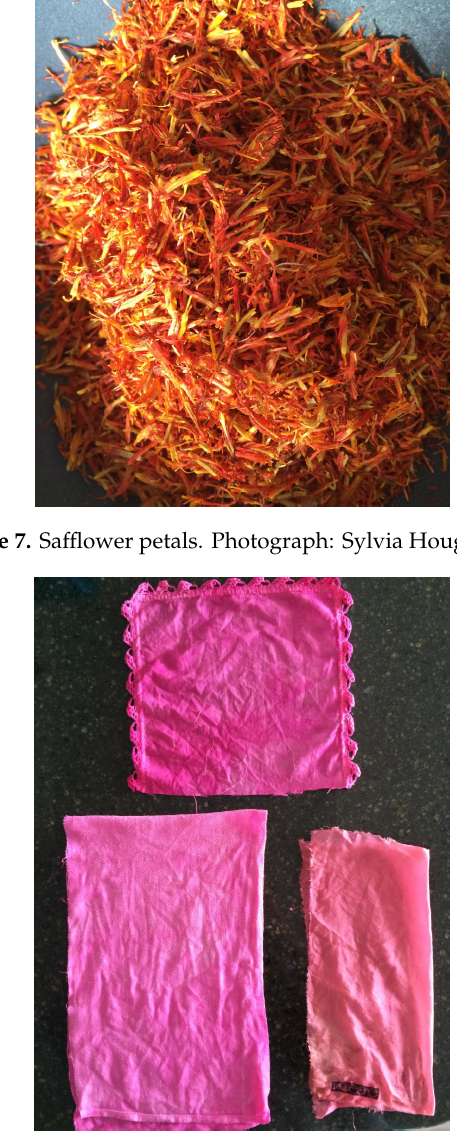
Figure 8 Figure 8. Cotton, linen, and silk dyed in sa ffl ower by the author. Photograph: Sylvia